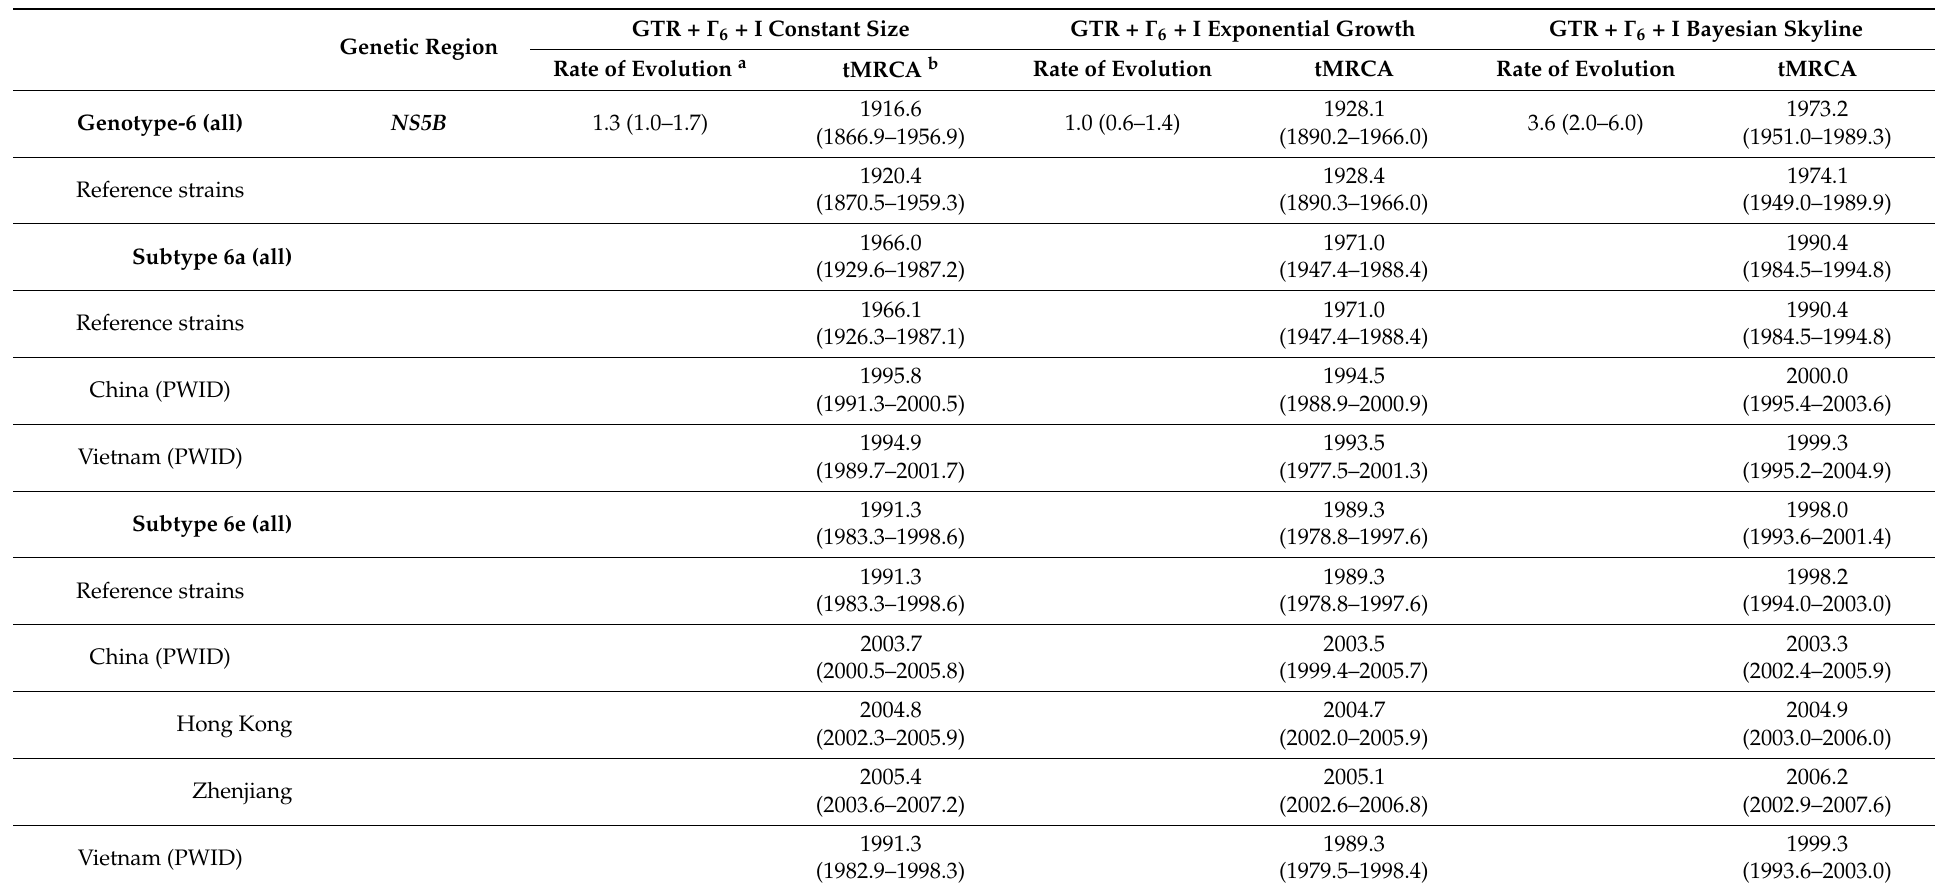
Table 2. Evolutionary characteristics of HCV subtype